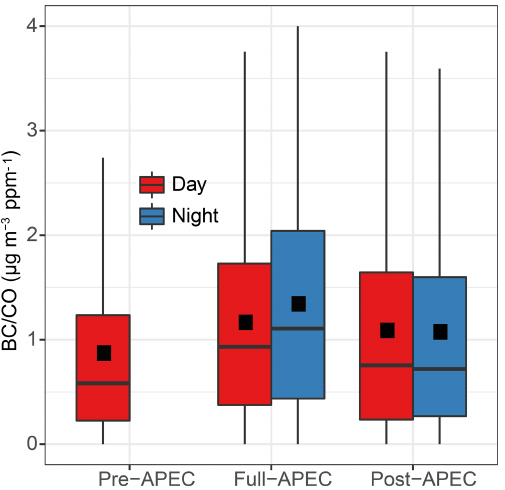
Figure 9. The distributions (boxplots) of BC / CO ratios derived from C veh . obtained from the WTM for the pre-, full-, and post- APEC periods. The black boxes and whiskers denote the 5th, 25th, 75th, and 95th percentiles. The black horizontal bars indicate me- dian values. The black squares represent mean values. Red boxes indicate observations in the daytime and blue boxes indicate obser- vations in the night-time.